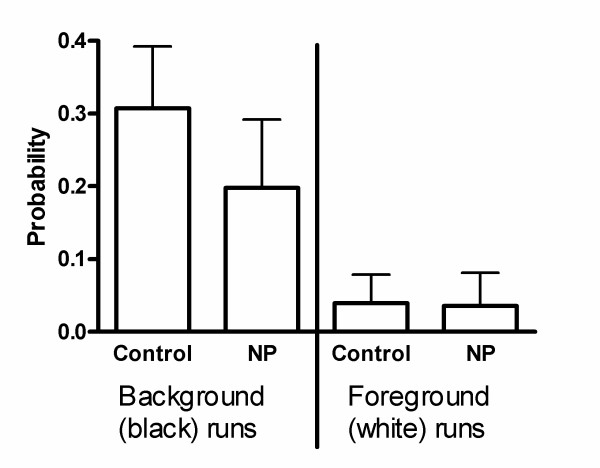
Statistical comparison of the probability that any run belongs to the 75% longest runs. Error bars indicate standard deviation. In the control images, background runs are 40% more likely to belong to the group of longer runs (P < 0.05) than in the nanoparticle images. Foreground runs do not show this difference.